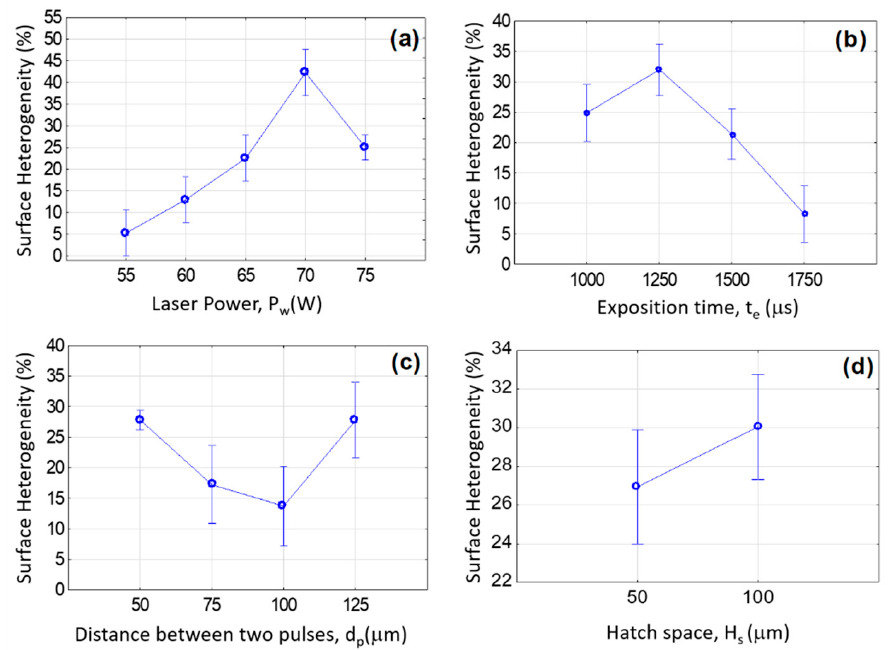
Figure 15. Statistical effects on the surface heterogeneity for different LM parameters. ( a ) The laser power effect, ( b ) the laser exposition time effect, ( c ) the distance between pulses, and ( d ) the hatch space.